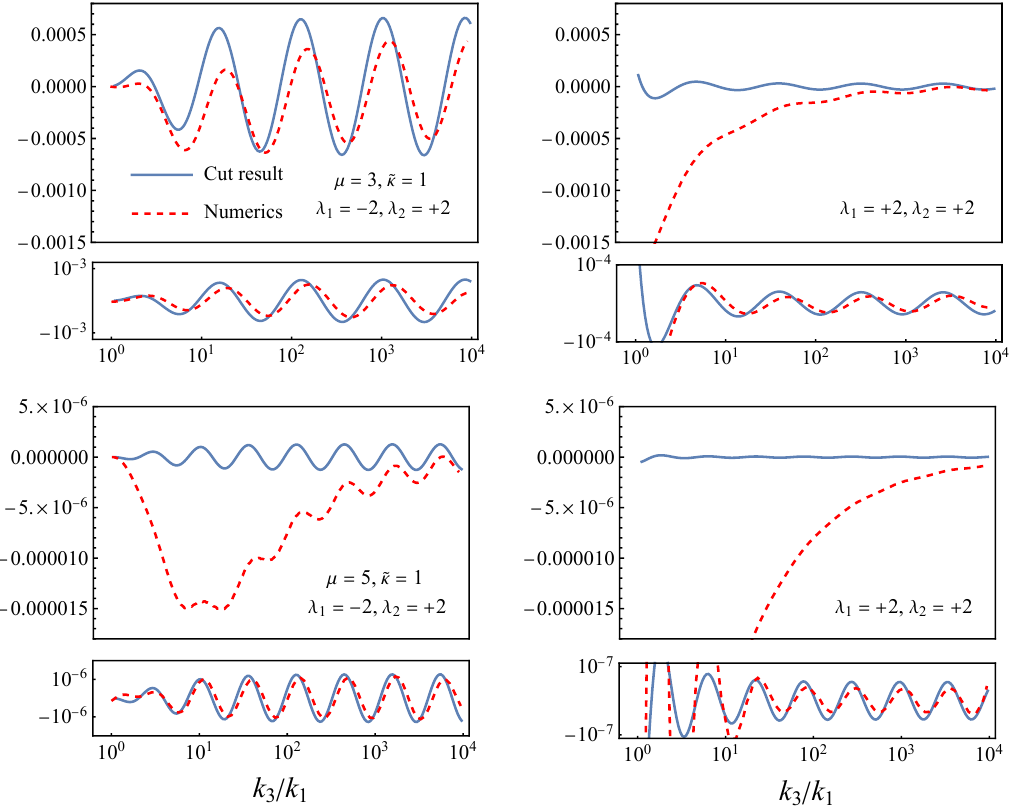
γ λ ζ i correlator for different choices of mass µ and chemical ( ii ) 1 2 h γ λ ( k 1 ) γ λ ( k 1 ) ζ ( k 3 ) i 0 / ρ 2 ˙ φH 3 , with 1 ( ii ) MM 4 p Λ c 1 2